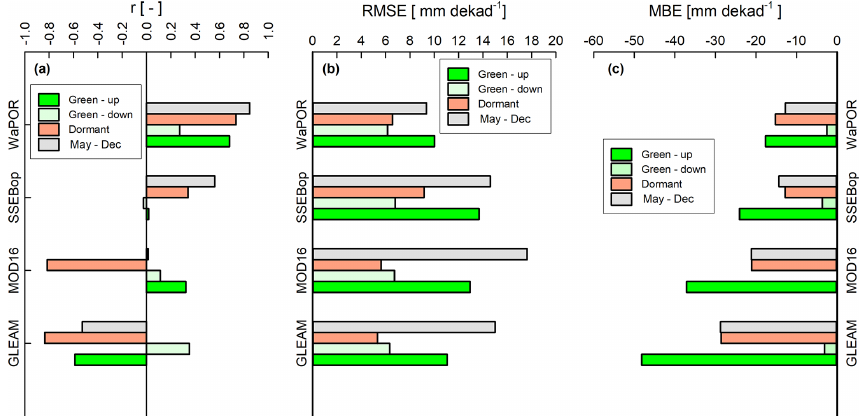
Figure 13. (a) Statistics of the correlation of E a ( DTS ) with satellite-based estimates, and (b, c) statistics of uncertainty in satellite-based evaporation estimates with reference to E a ( DTS ) for each phenophase and for the entire study period May–December